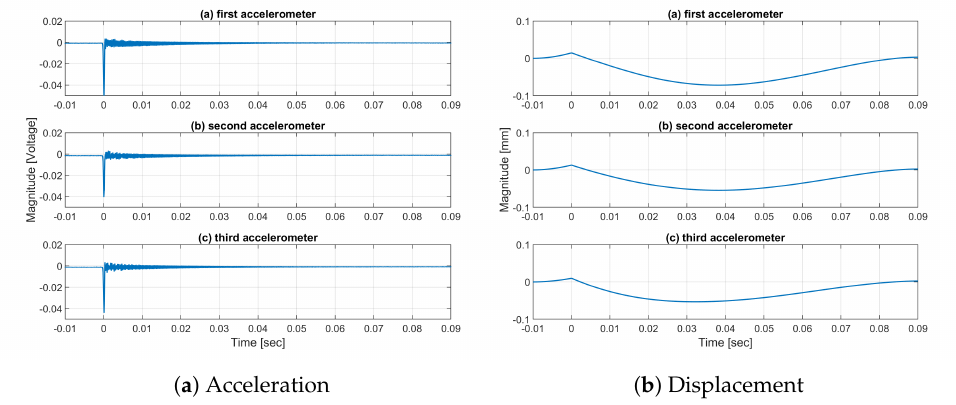
Figure 11. Typical acceleration and displacement results of the fully glued 120 grit